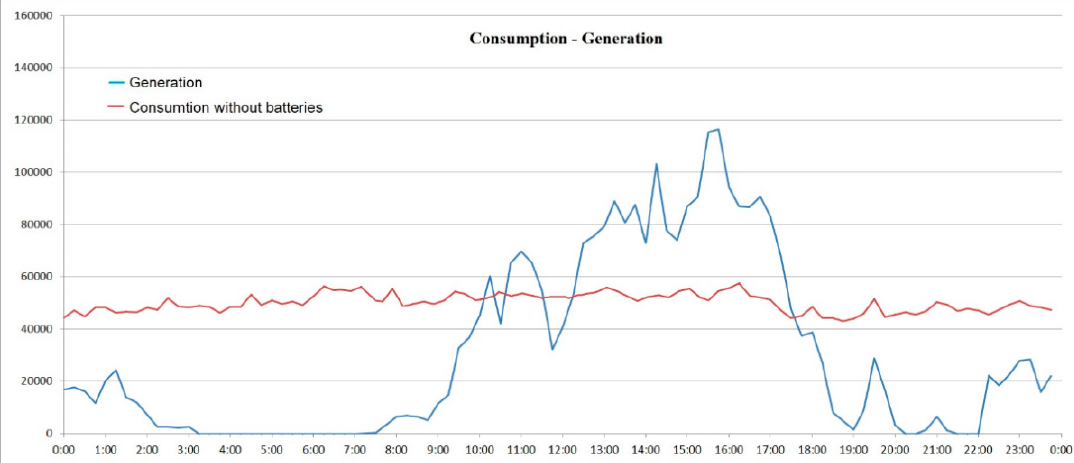
Figure 10. Daily grid generation–consumption graphic (before implementation). Source: prepared by authors based on the results of this study.